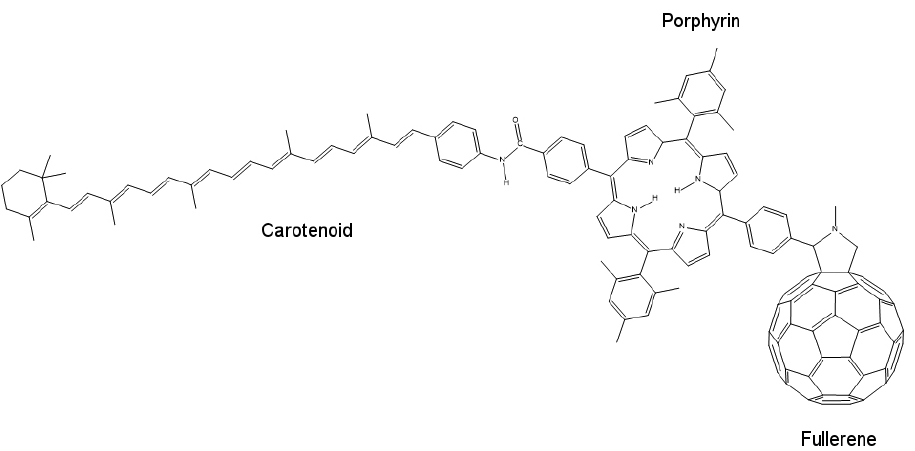
Figure 10. The molecular structure of an artificial reaction center, showing its constituent molecules porphyrin, fullerene and